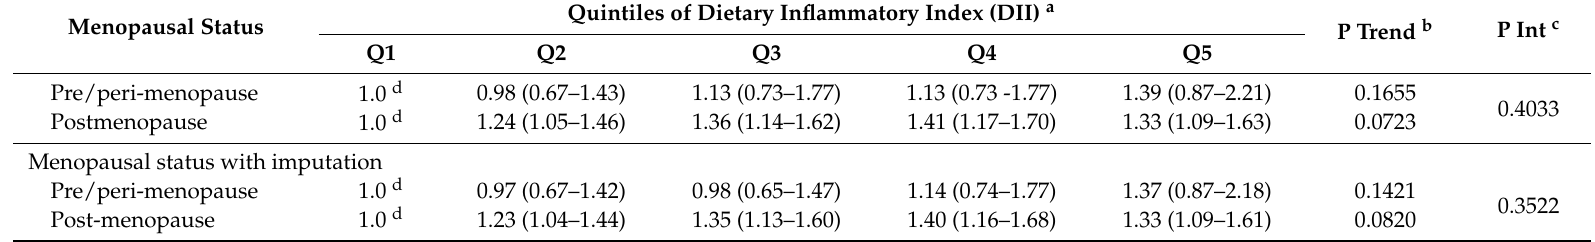
Table 3. Multivariate Cox Proportional Hazard Ratios (HRs) (95% Confidence Intervals (CIs)) for osteoporosis risk as stratified by menopausal status among women in the KOGES cohort,